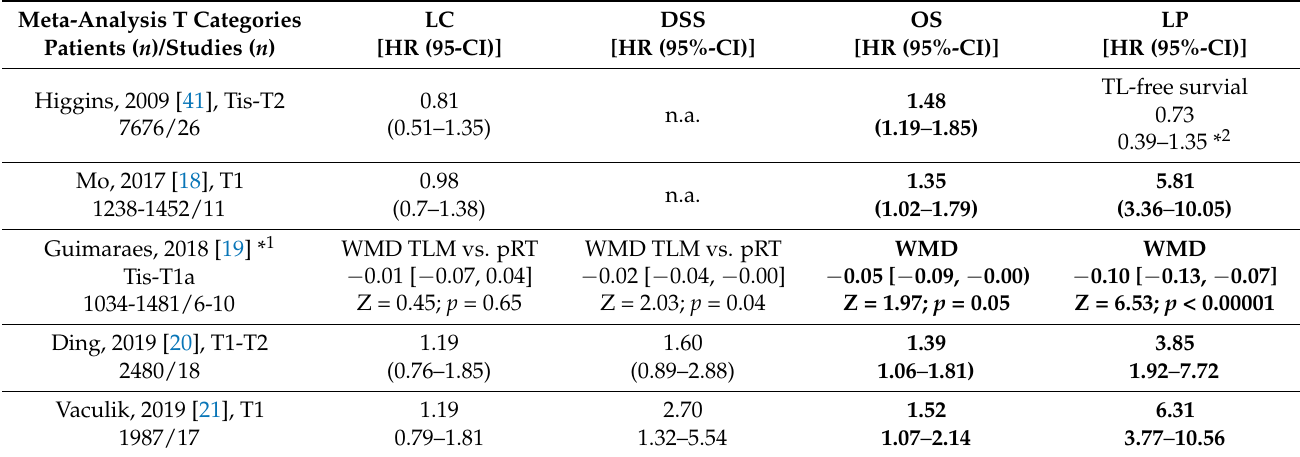
Table 5. Comparison of outcomes between TLM and pRT in early-stage glottic